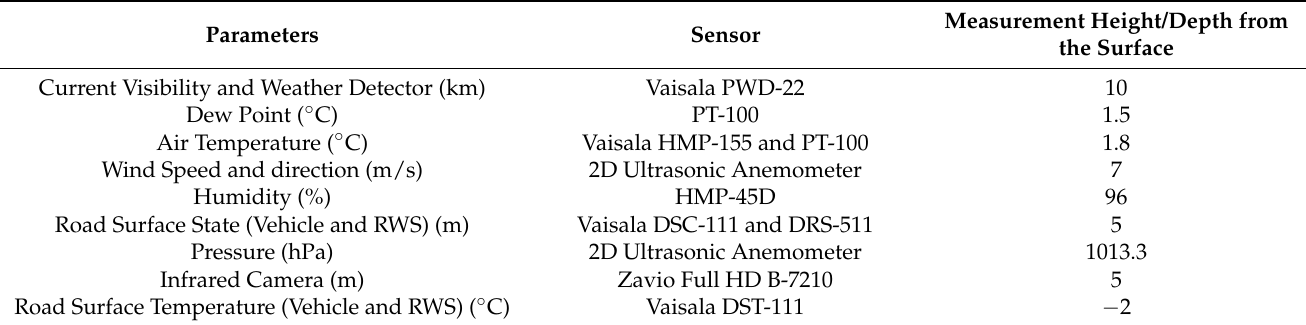
Table 2. RWS and vehicle data collected during the V2V and V2I